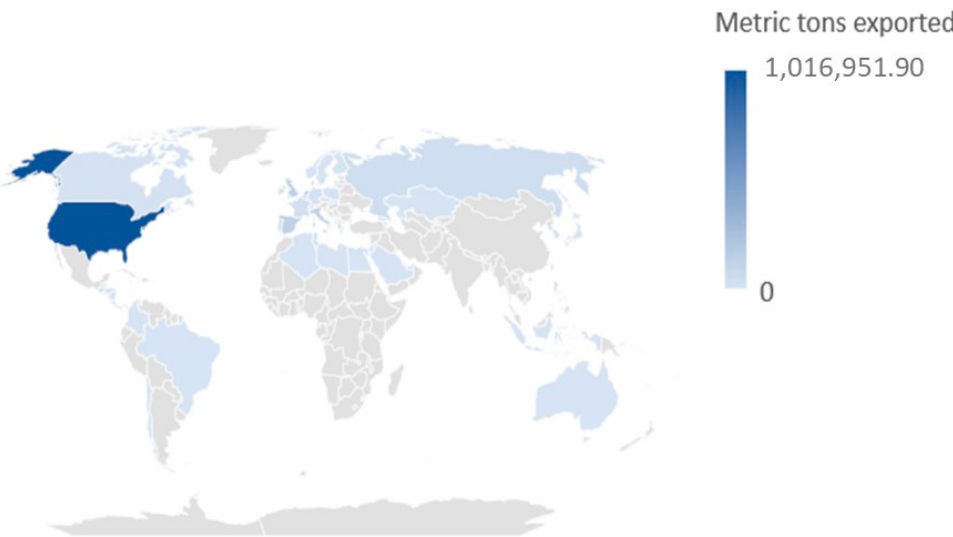
Figure 1. Geographical distribution of the Costa Rican pineapple exportations during 2020 (the first year of the COVID-19 pandemic).